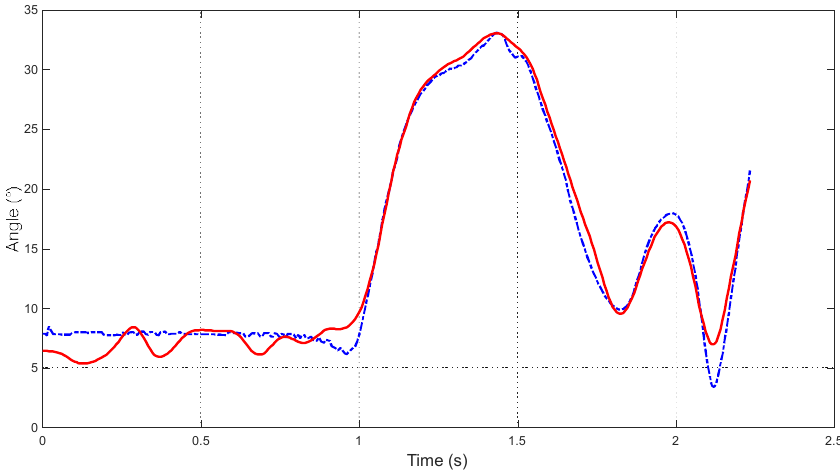
Figure 3. Thigh angle during a stand-to-walk trial measured by depth-camera (solid red line) and motion capture (dashed blue line) for self-paced walking at 1.1 m camera